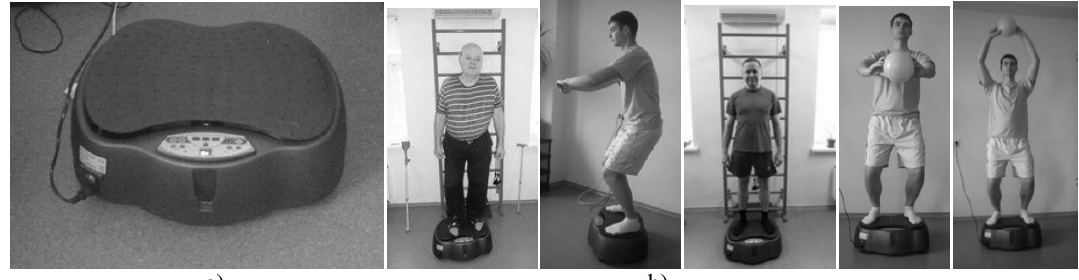
Fig.2. Vibration platform –stimulator ViaGym (а) and exercises, fulfilled on it